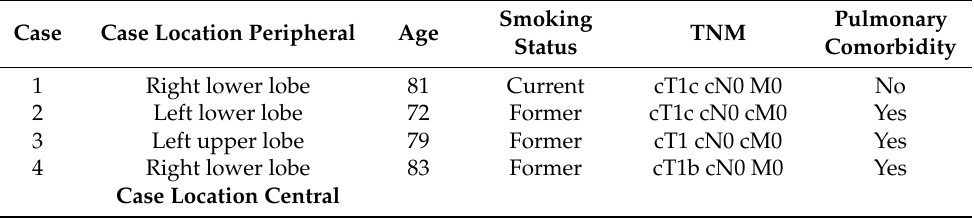
Table 1. Patient